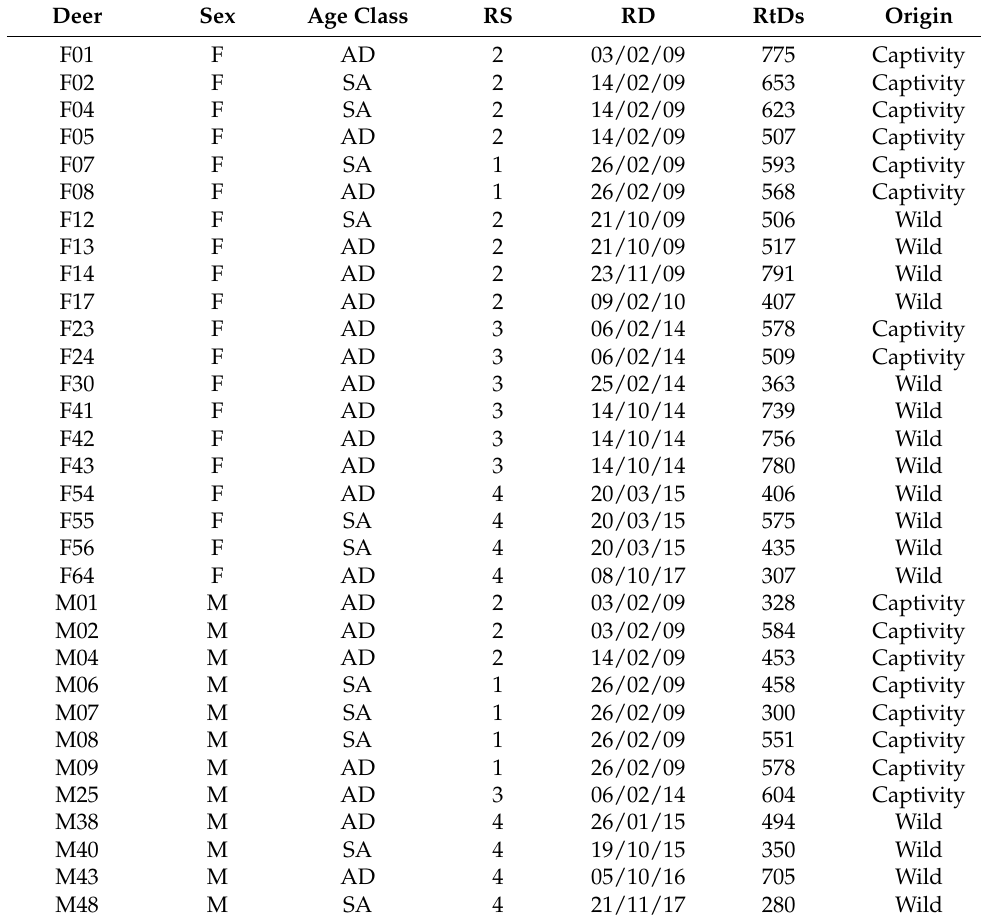
Table 1. GPS-tracked Corsican red deer and main individual characteristics.